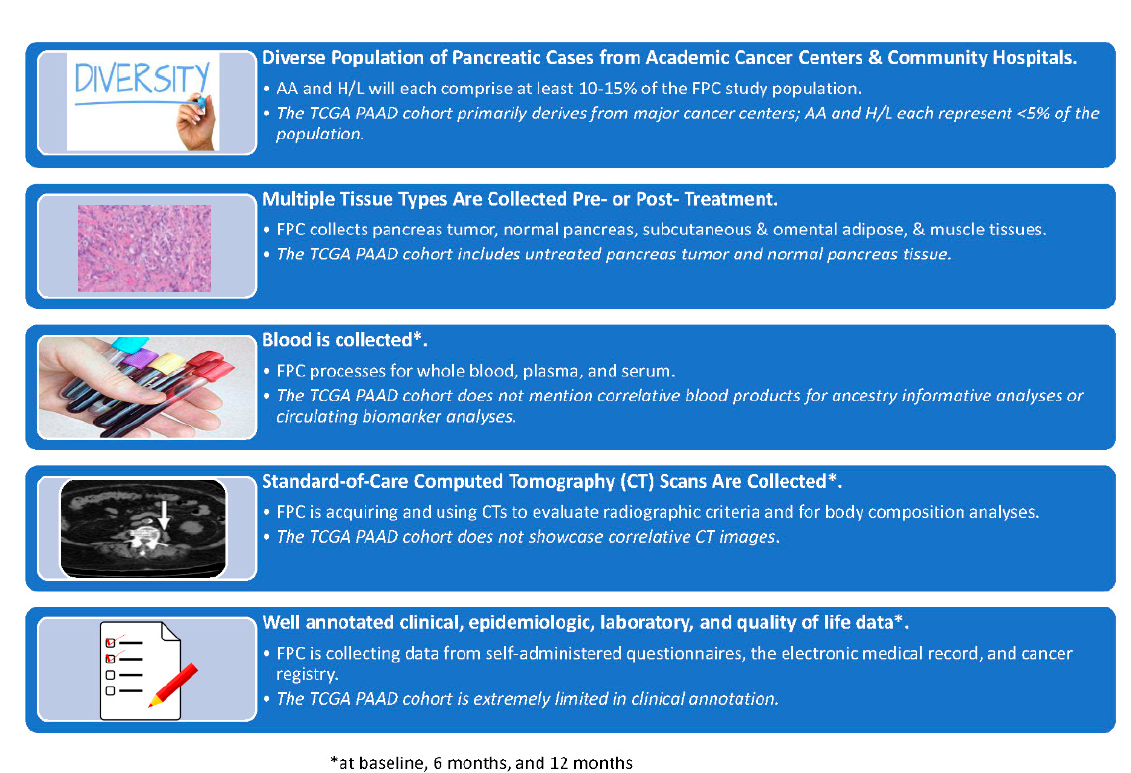
Figure 4. Resources Ascertained through the Florida Pancreas Collaborative (FPC) versus the Pancreatic Ductal Adeno- carcinoma (PAAD) Cohort included in The Cancer Genome Atlas (TCGA) Pan-Cancer Analyses. This comparison reveals that the FPC: (a) includes participants recruited from the community and has a higher proportion of underserved minority populations, (b) collects tissue types (untreated and treated) in addition to pancreas tumors and normal pancreas, and has (c) correlative blood, (d) CT scans, and (e) well-annotated data corresponding to each participant. Note: The PAAD cohort being referred to was published by Liu et al. [48].